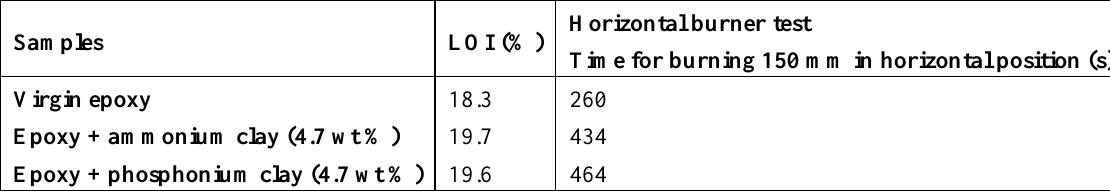
Table 1. Flammability characteristics of clay-filled epoxies. Data from